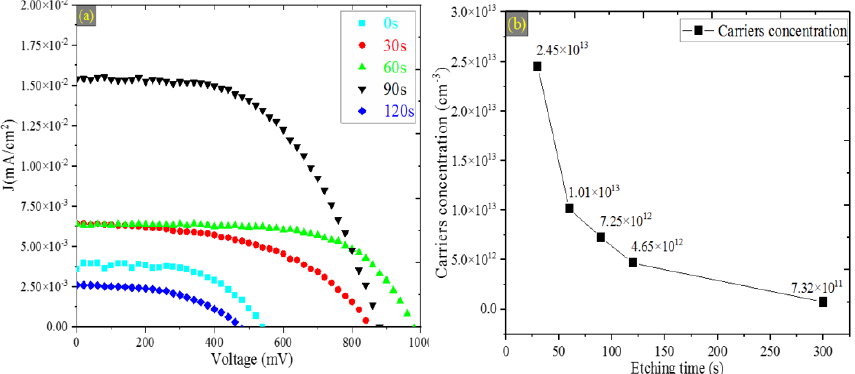
Figure 4. Etching time-dependent ( a ) J-V curves Al/c-Si/PSi/Ag, and ( b ) carriers concentration of PSi.